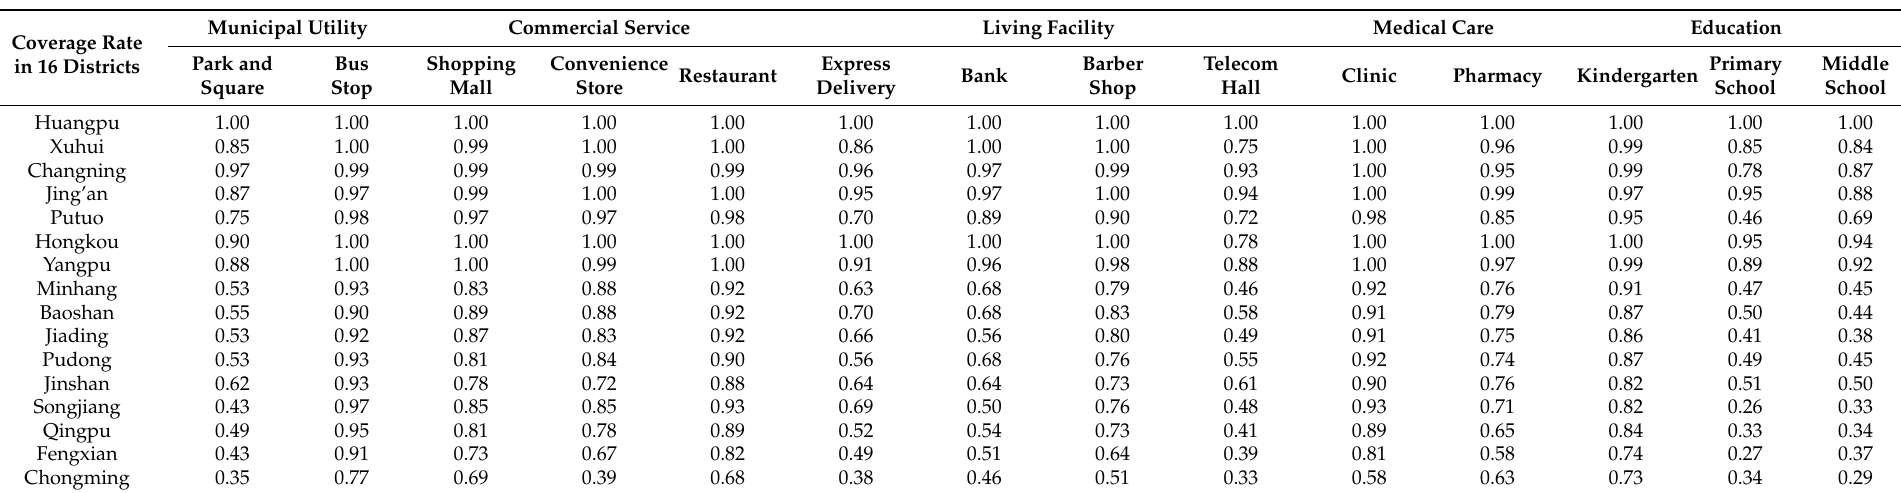
Table 3. Facility